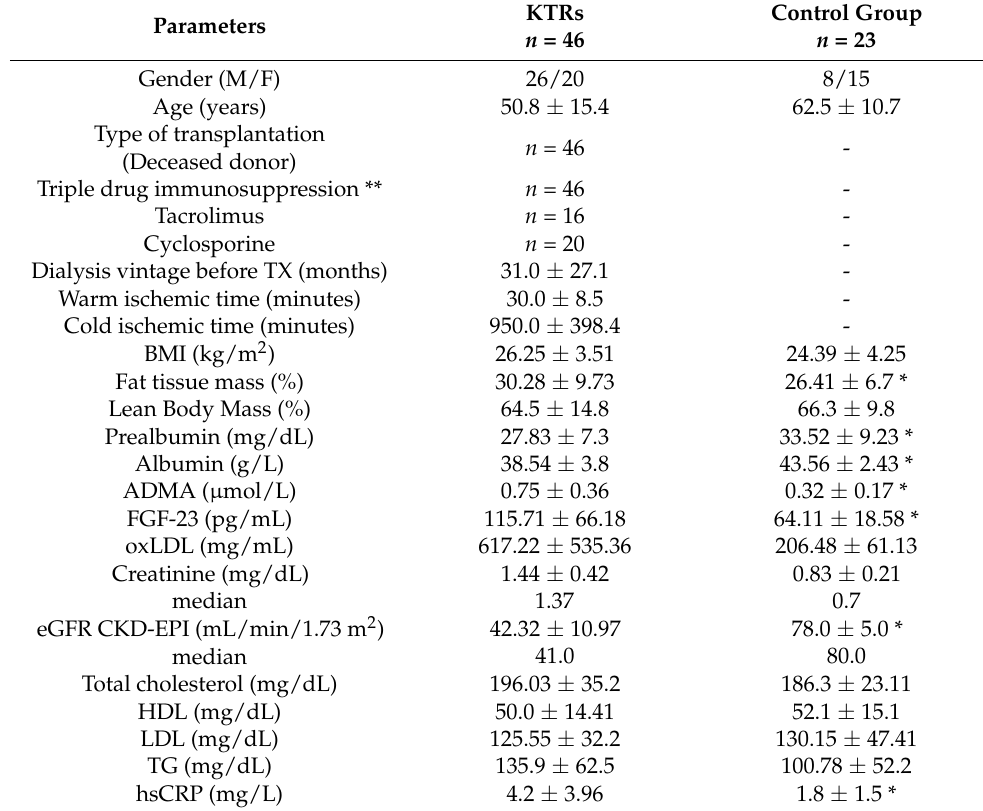
Table 1. The comparison between KTRs and control group.